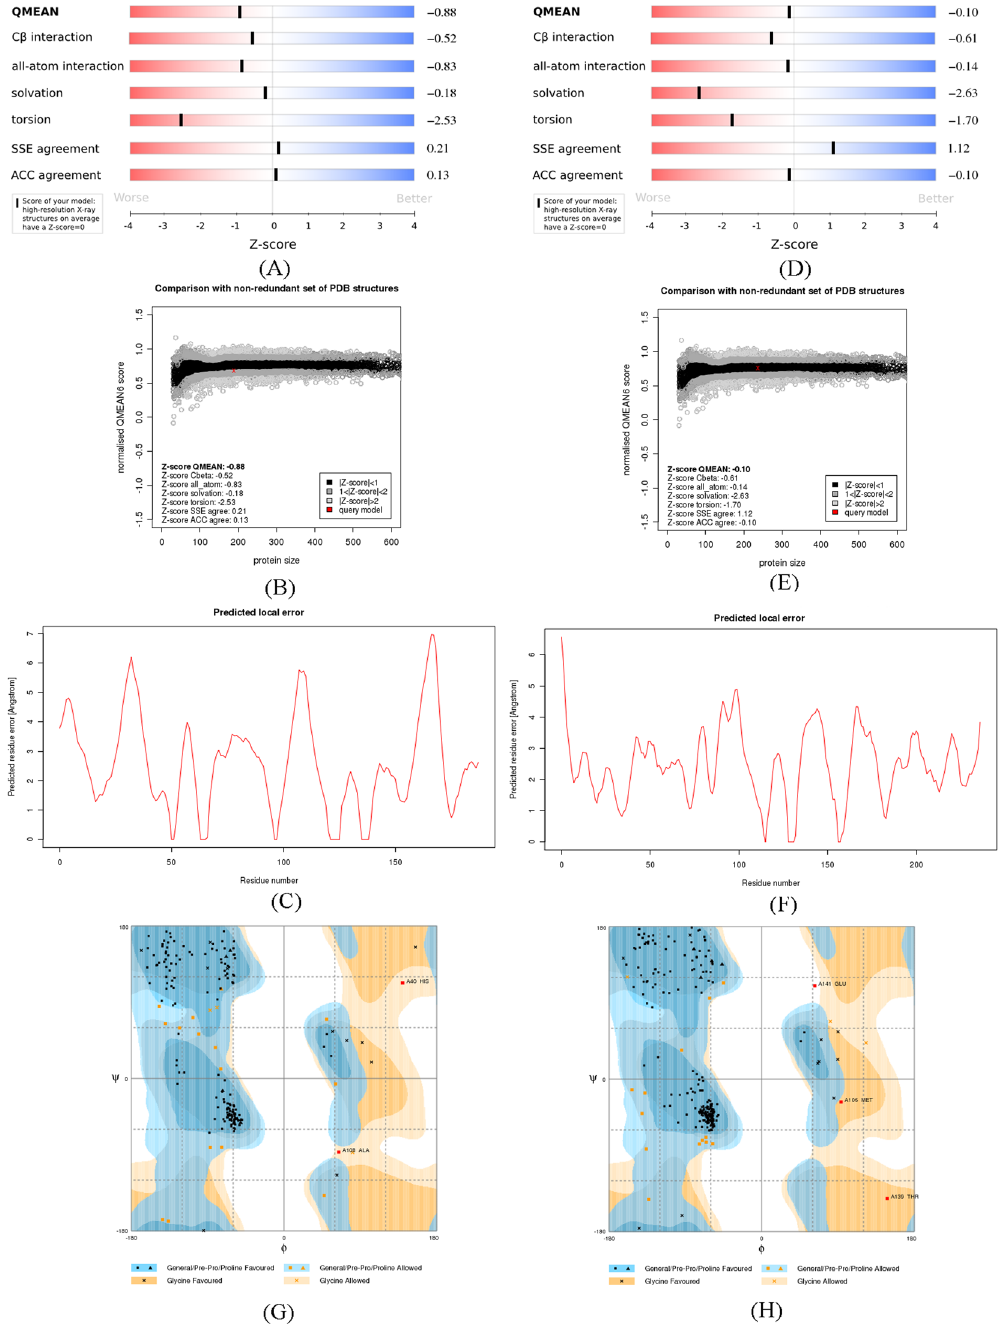
Figure 7. Assessment of the quality of LuxI (1-3) and LuxR (4–6) type proteins of A. sobria by SWISS-MODEL and RAMPAGE (7: Ramachandran Plot Analysis of LuxI type protein; 8: Ramachandran Plot Analysis of LuxR type